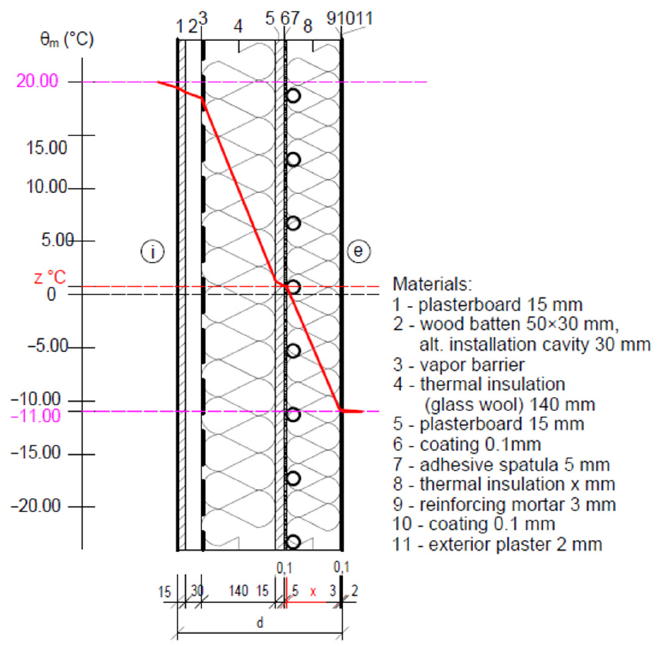
Figure 30. Mathematical-physical model of the test cell wall. θ m —the temperature in construction (°C), d—construction thickness (mm), x—thickness of thermal insulation (mm), z—the temperature between the load-bearing and thermal insulation layer of the structure (°C), e—exterior, and i—interior.